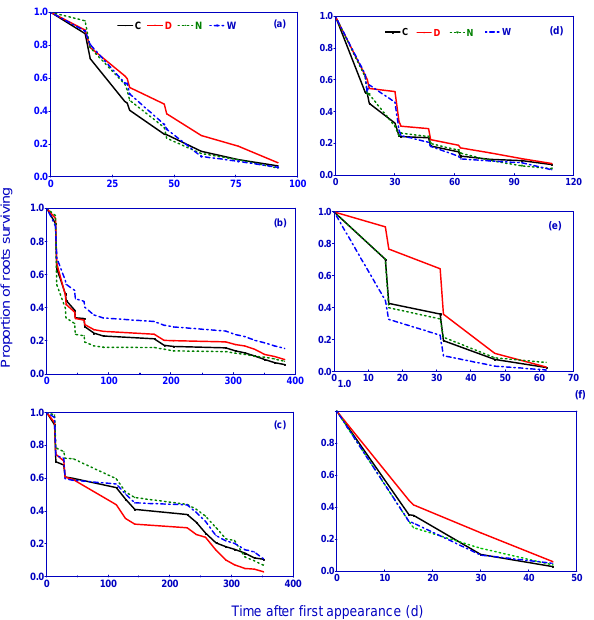
Fig. 2. Survival curves of roots born in spring (a, d) , summer (b, e) and autumn (c, f) in 2008 and 2009 under the control (C) and day warming (D), night warming (N) and continuous warming (W) at soil depth of 0–30cm. Data were based on the total numbers of 3450, 4100 and 3337 individual roots born in spring, summer and autumn in 2008, and 1780, 334 and 1093 individual roots born in spring, summer and autumn in 2009. The Kaplan–Meier method was used to generate curves. Survival differences between different Fig. 3 1 treatments were compared using Log-rank test.